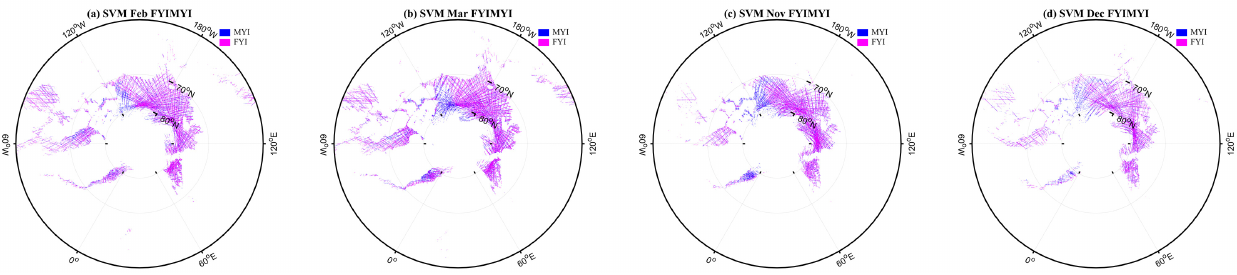
Figure A19. SVM for FYI-MYI classification using the data in November as the training set. The data in ( a ) February, ( b ) March, ( c ) April, and ( d ) December are used as the test set in turn.